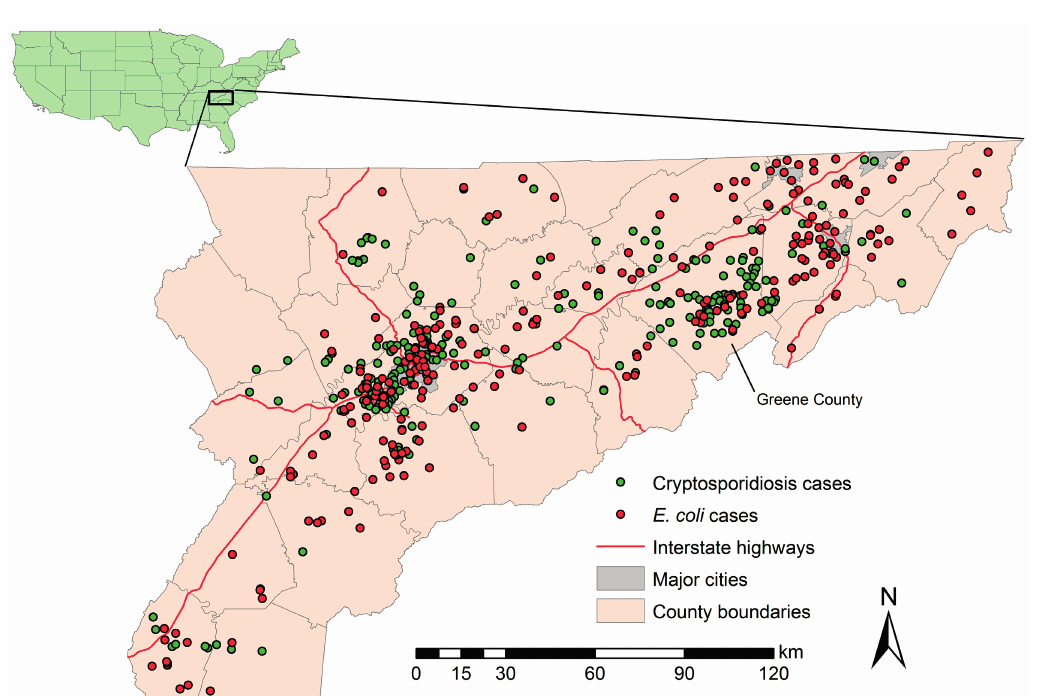
Figure 1. Study area and approximate locations of disease cases from 2000 to 2010.